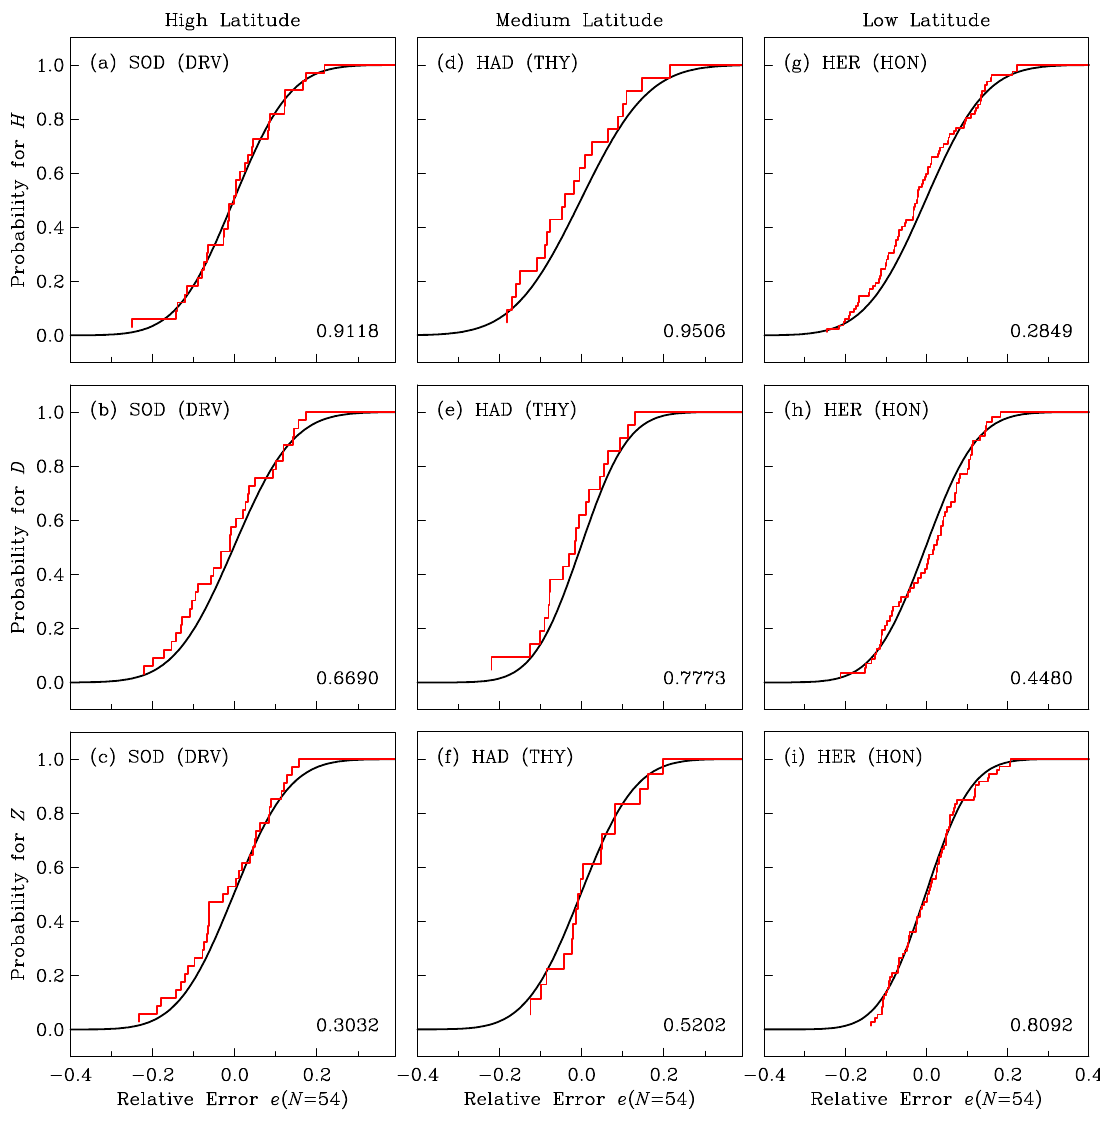
Fig. 6. Cumulative distributions of relative error results for the 90% (10%) rule with 6 missing minutes, e(N = 54 ) , and comparison dis- tributions for zero-mean normal (Gaussian) distributions having similar variances, for (a–c) H , D , and Z magnetic-vector components for high-latitude observatories SOD (DRV), (d–f) medium-latitude observatories HAD (THY), (g–i) low-latitude observatories HER (HON). Also given, in each case, are the Kolmogorov-Smirnov probabilities of